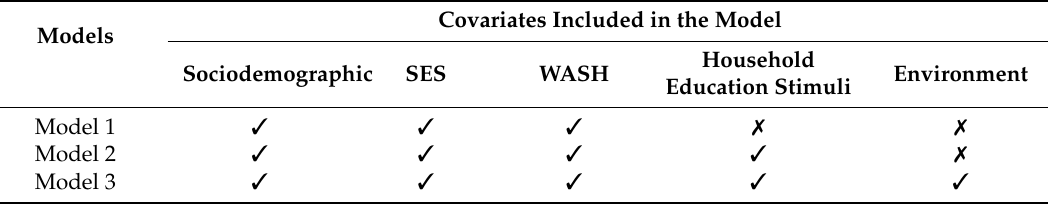
Table A1. List of covariates included in the